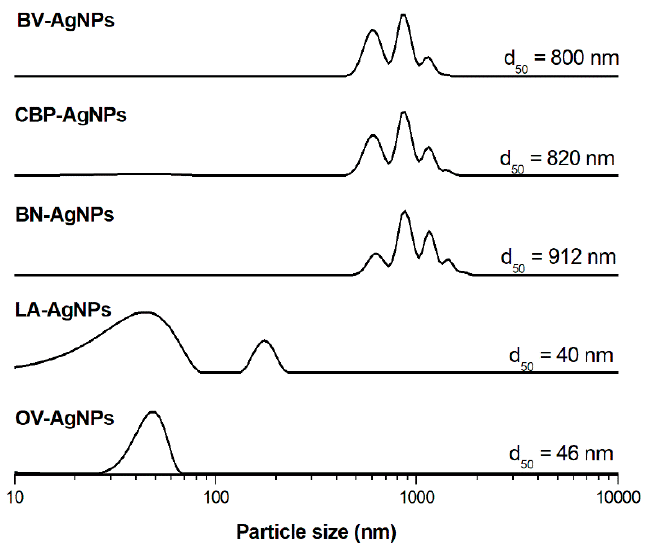
Figure 3. Grain size distribution of biosynthesised AgNPs from 5 mM AgNO 3 determined by PCCS.